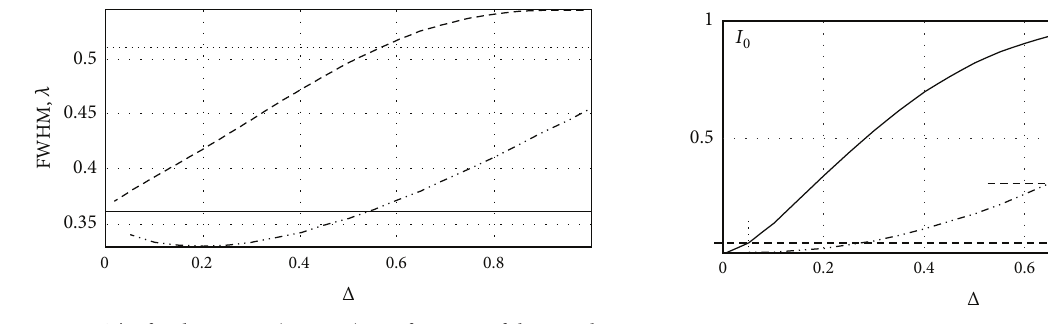
Figure 3: Normalized focal point intensity as a function of the annular aperture’s width ( Δ ) without (solid bold line) and with a radial phase jump (dotted